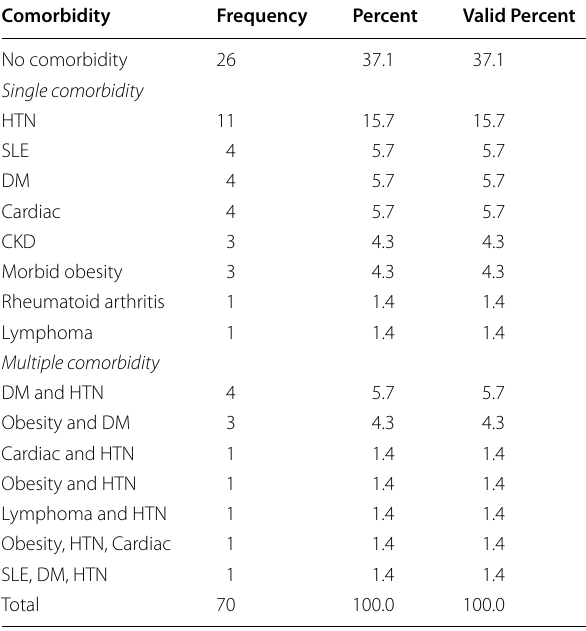
Total HTN patients were 20 (28.6%), Total DM patients were 12 (17.1%), total morbid obesity patient 8 (11.4%), total cardiac patient 6 (8.6%), total lymphoma patients were 2 (2.9%)